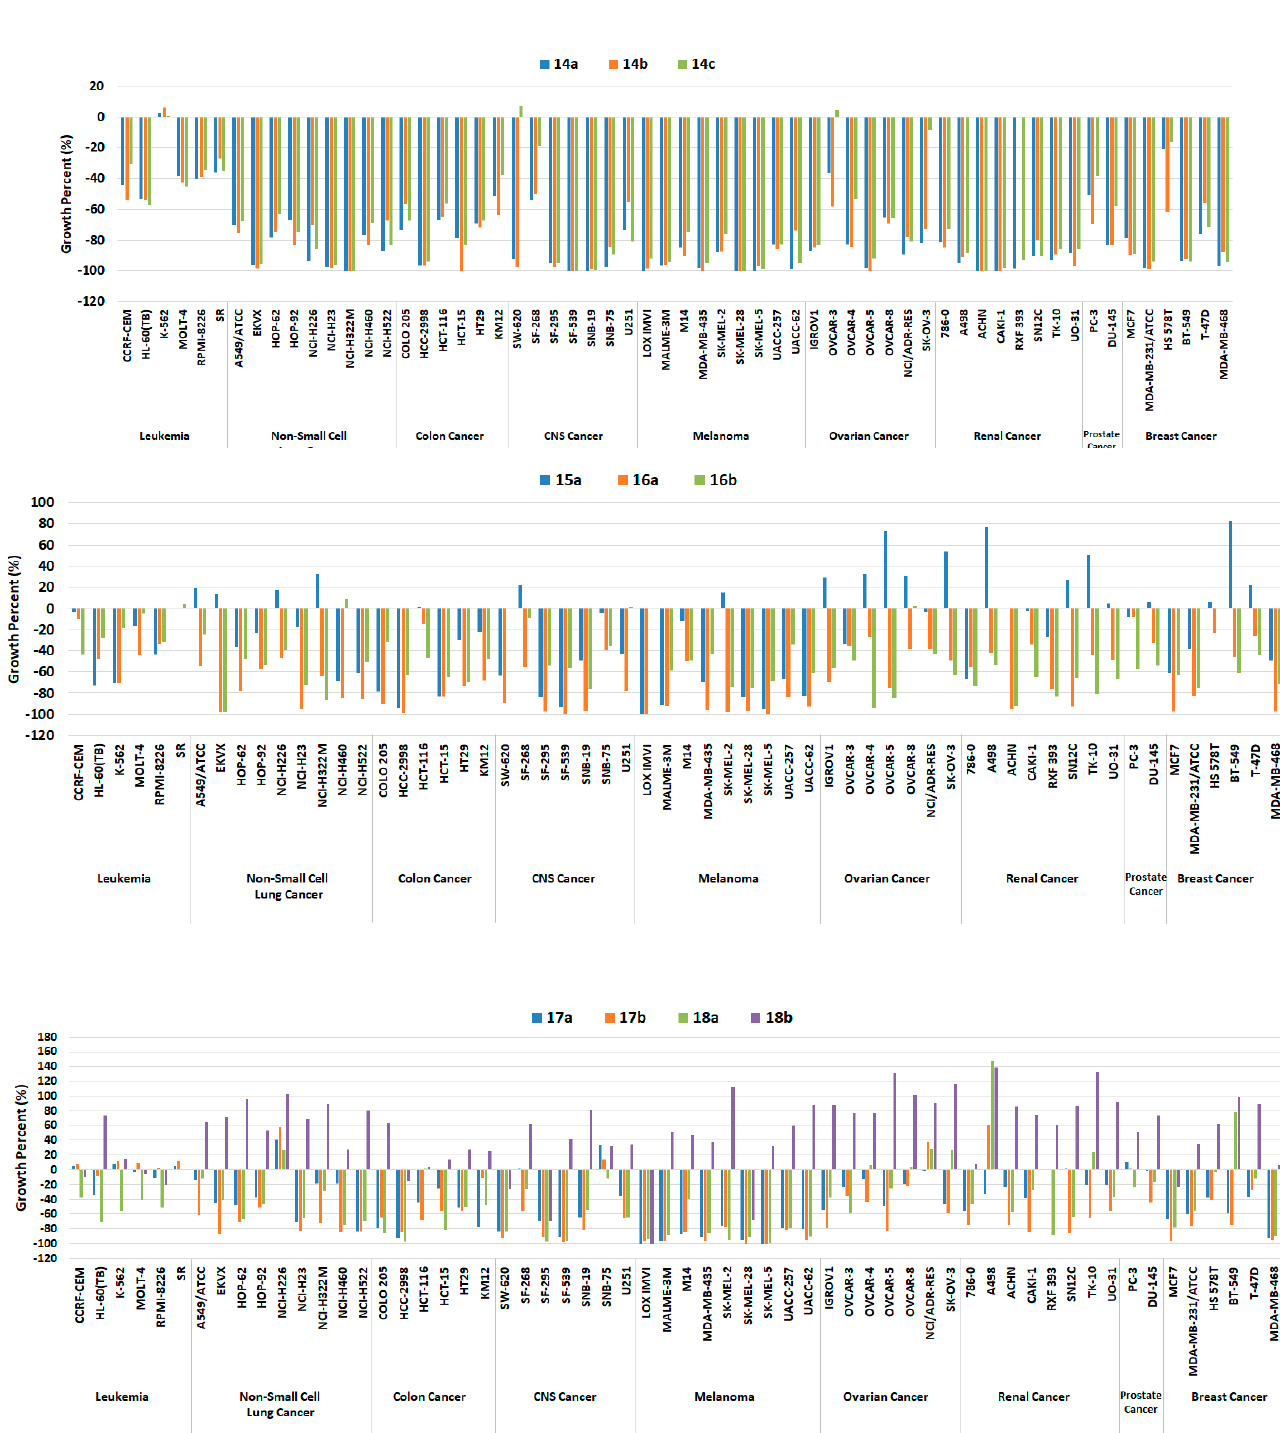
Figure 5. Growth percentage of the NCI-60 human tumor cell lines upon treatment with 10 µM of compounds 14a – c (upper panel), 15a , 16a, and 16b (middle panel), 17a , 17b , 18a , and 18b (lower panel).